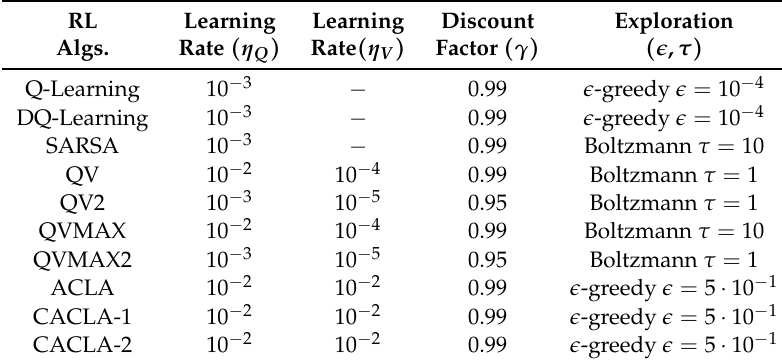
Table 2. Controller parameters